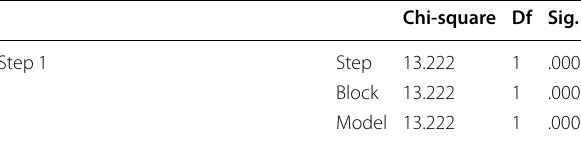
Chi-square Df Sig.